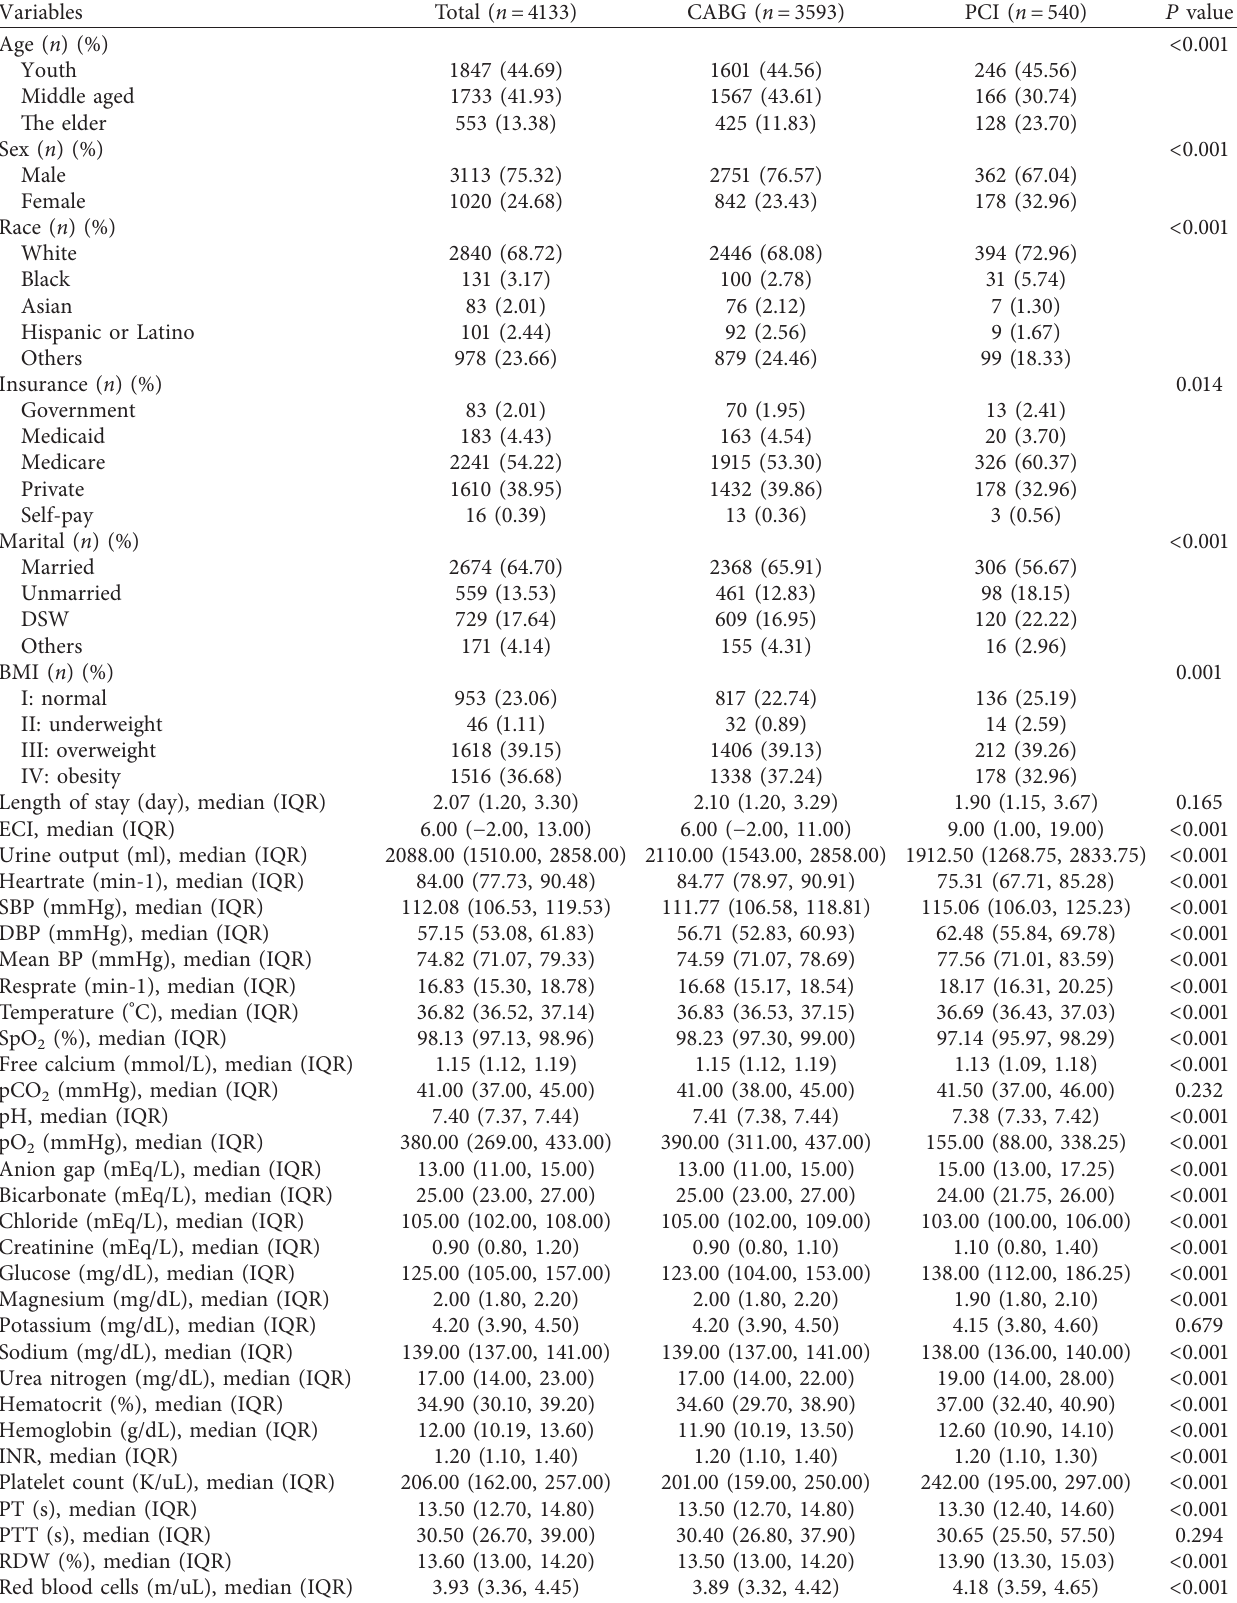
Table 1: Baseline